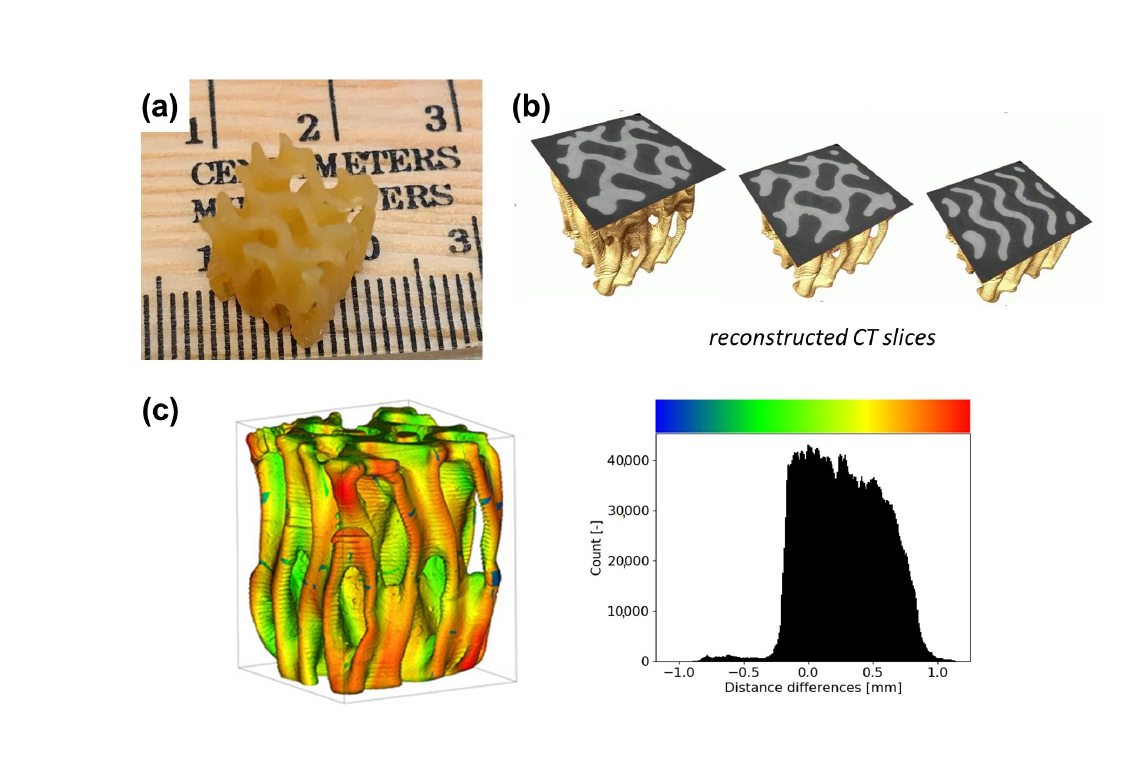
Figure 4. 3D-printed gyroid sample. ( a ) Picture of the 1 × 1 × 1 cm 3 printed sample. ( b ) Reconstructed slices of the sample taken at multiple heights showing different layers and the fully dense structure of the sample. Image rendering was performed with Avizo Lite 9.5.0 (FEI Visualization Sciences Group, Burlington, MA). ( c ) Surface distance measurement between prescribed and printed sample. Colors indicate local displacement of the printed sample in positive (yellow and red shades) and negative (green and blue shades) directions. Histogram of the measurement shows a broad peak center around 0.25 mm.